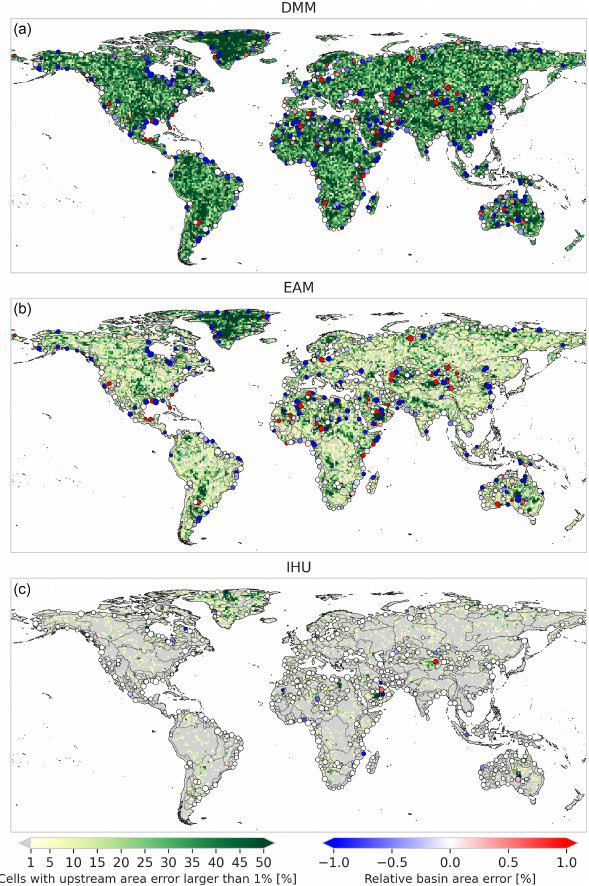
Figure D2. Percentage of cells at a 15arcmin ( ∼ 30km) resolution per 1 × 1 ◦ tile with an absolute relative upstream area error of more than 1%. The markers show the upstream area error at the basin outlet and the black lines the outlines of the 200 largest basins glob-